Question: What kind of plot is shown here?
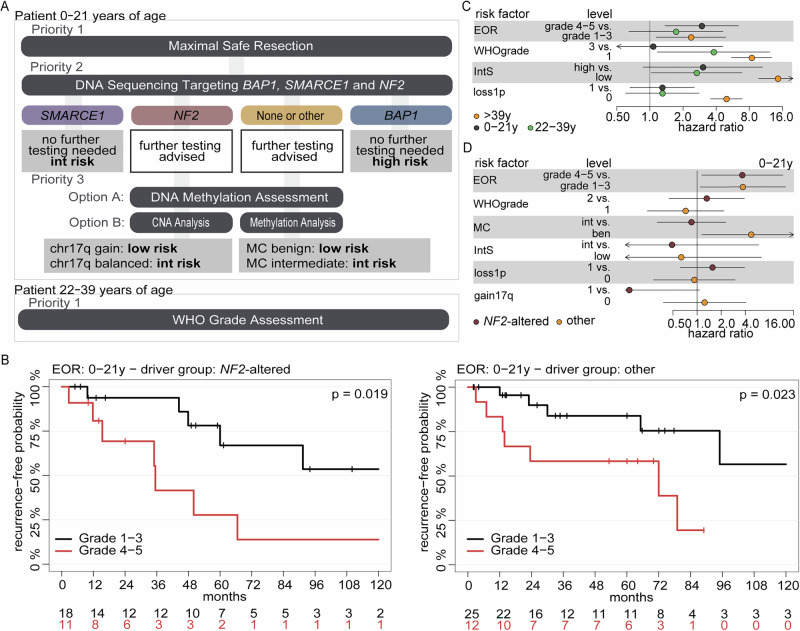
Answer: survival